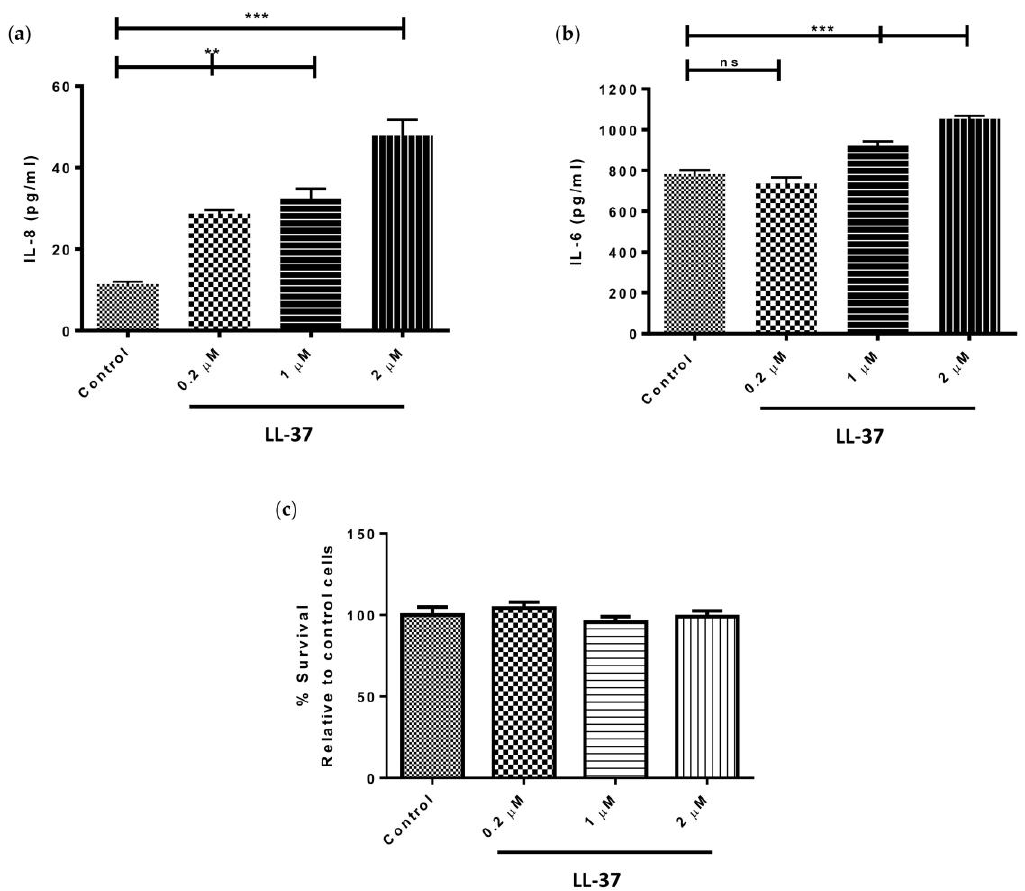
Figure 1. Direct effects of LL-37 on secretion of the pro-inflammatory cytokines ( a ) interleukin (IL)-8 and ( b ) IL-6 by gingival fibroblasts. Cells were incubated in medium containing the vehicle only (Control) or vehicle and peptide (0.2, 1, or 2 µ M), (IL-8 mean ± SD, n = 3; IL-6 mean ± SD, n = 6); ( c ) The percentage cell survival of gingival fibroblasts, relative to that of control, following a 24 h exposure to 0.2, 1, or 2 µ M LL-37. Cells were incubated in medium containing the vehicle only (Control) or vehicle and peptide (0.2, 1, or 2 µ M), (mean ± SD, n = 6). Data were analysed by one-way analysis of variance followed by Bonferroni’s multiple comparison test (ns = nonsignificant; ** = p < 0.01; *** = p < 0.001). For cell survival experiments, all comparisons were nonsignificant.